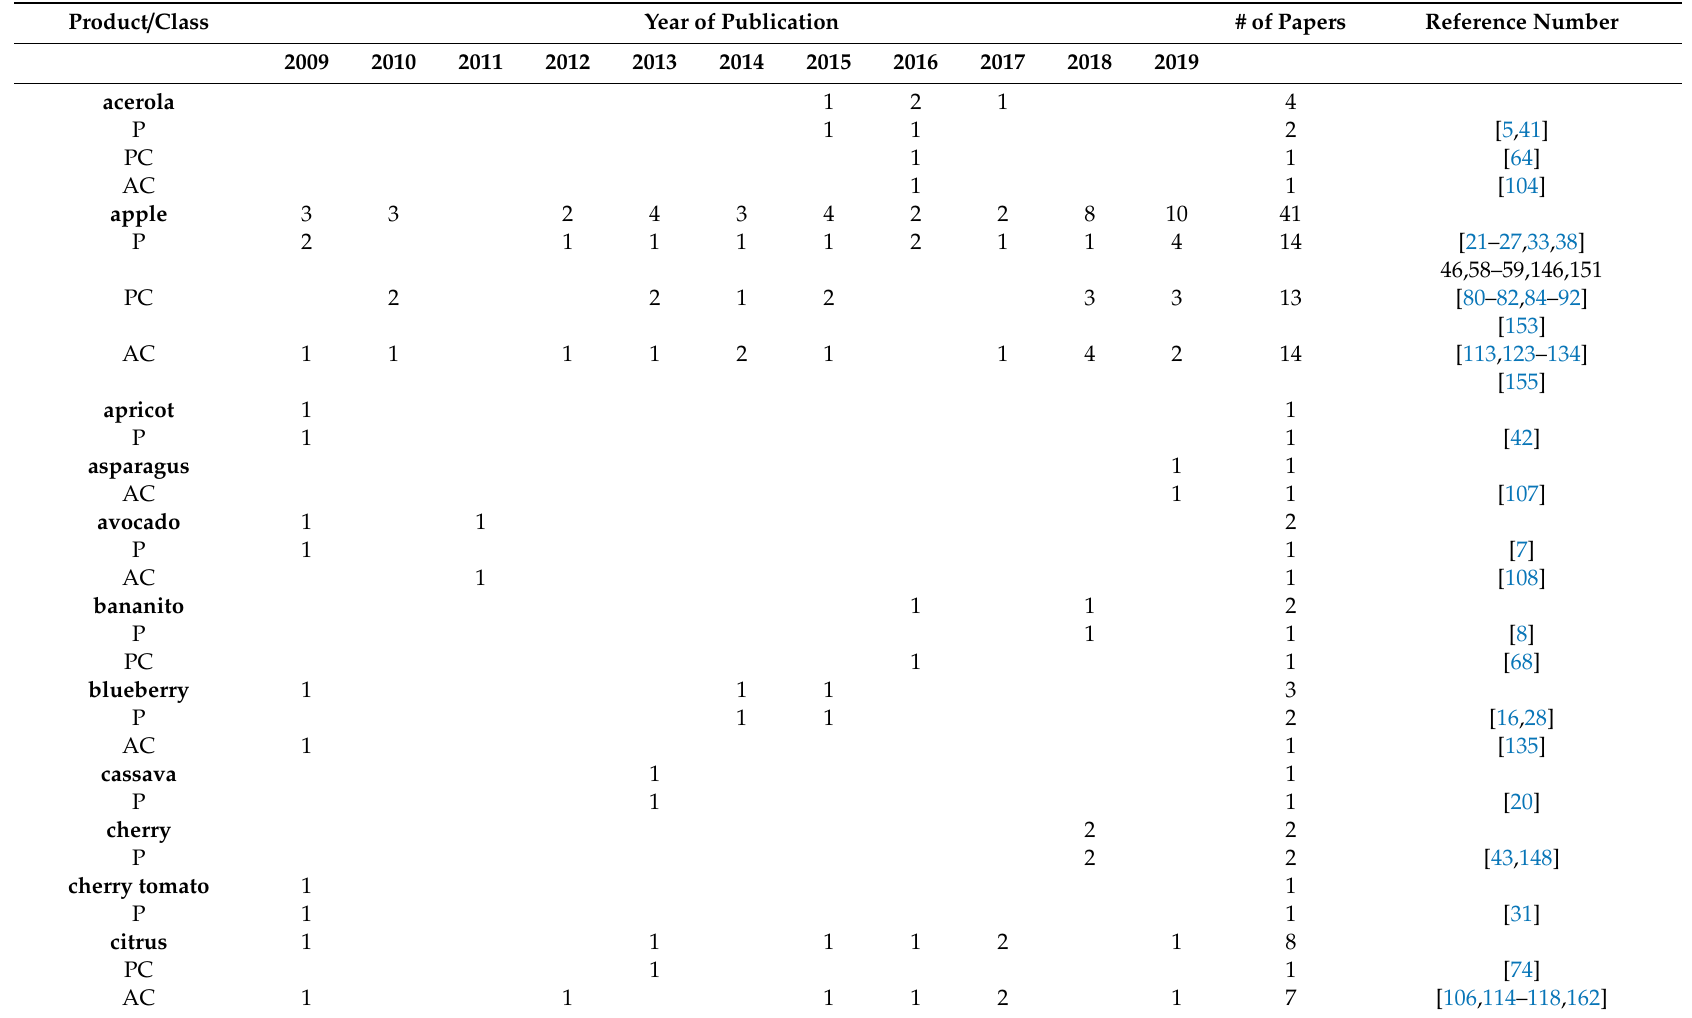
Table 1. List of papers reporting near infrared (NIR) applications in the horticultural